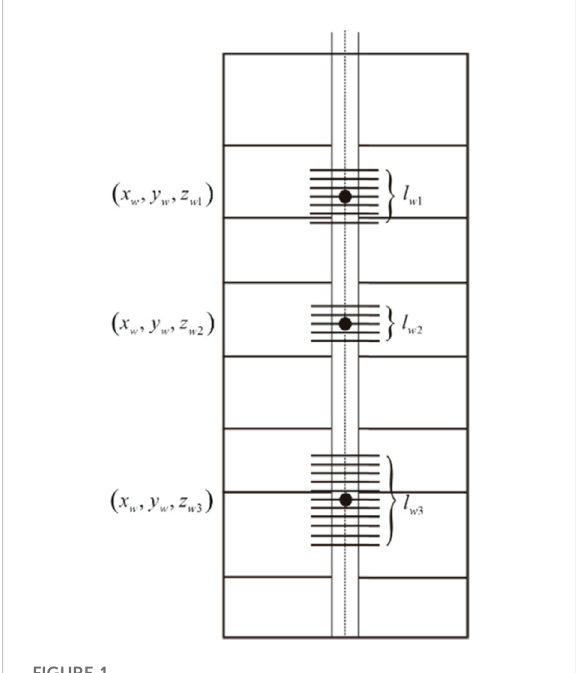
FIGURE 1 Schematic of perforations of a vertical well in multiple